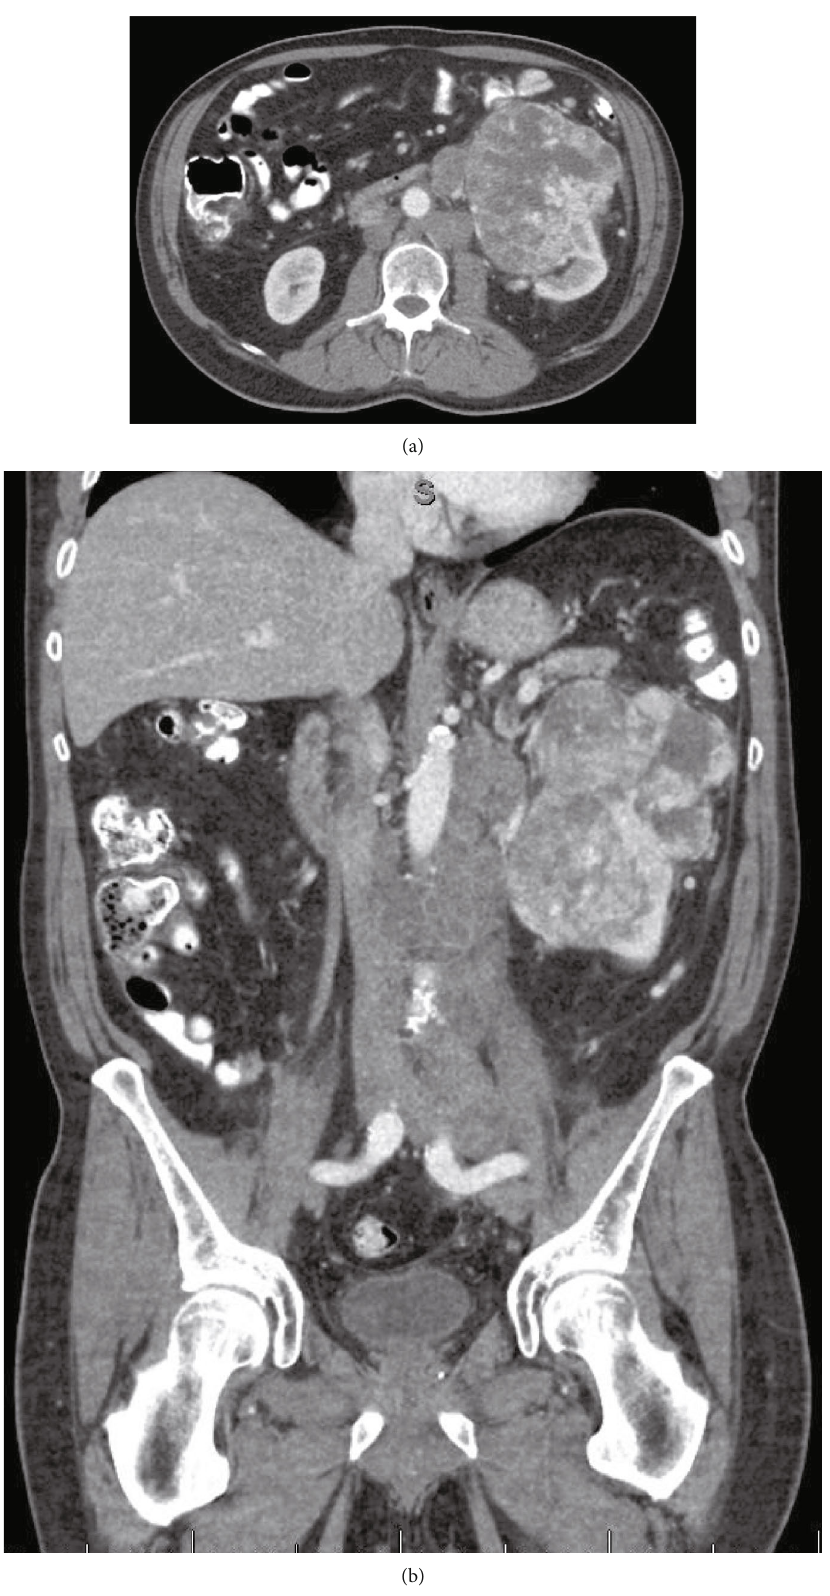
Figure 1: CT imaging prior to nivolumab/ipilimumab treatment: (a) axial imaging demonstrating the heterogeneously enhancing left renal mass; (b) coronal imaging demonstrating the enlarged retroperitoneal